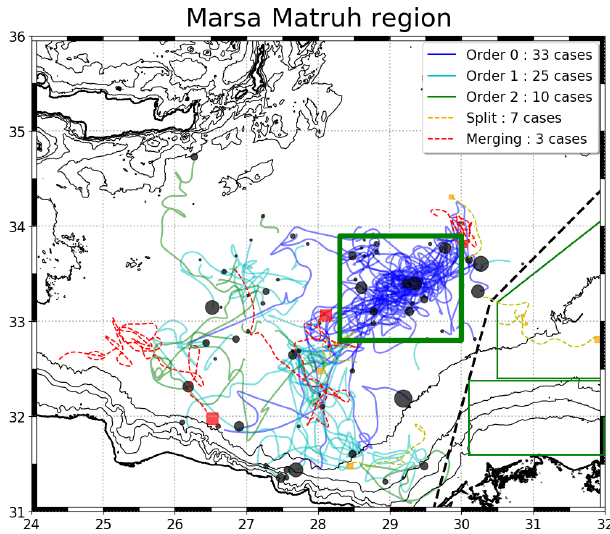
Figure 10. Convergence structure applied to the Marsa Matruh re- gion, administered in the same way and using the same color code as in Fig.